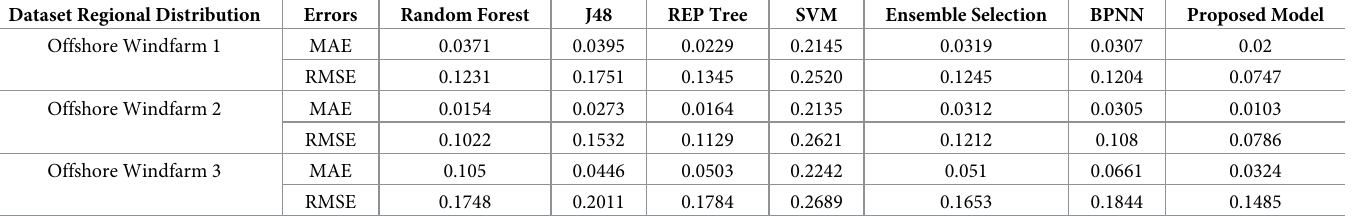
Table 5. Comparison of the mean absolute error (MAE) and root mean square error (RMSE) of the proposed model with other state-of-art forecasting methods for all three offshore windfarms. Dataset Regional